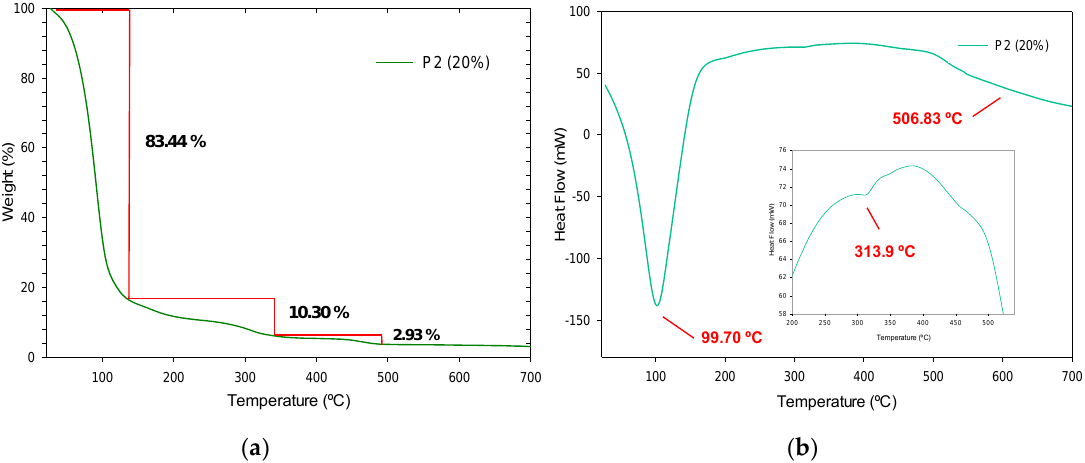
Figure 19. P2 (20%) results: ( a ) TGA analysis and ( b ) DTG thermogram. TGA graph of P3